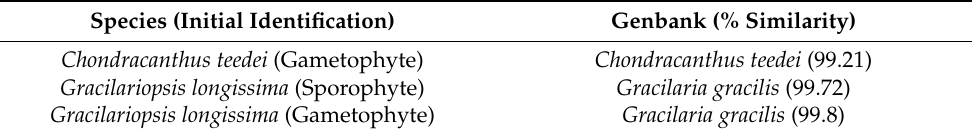
Table 2. Identification of the worked species by sequence analysis.